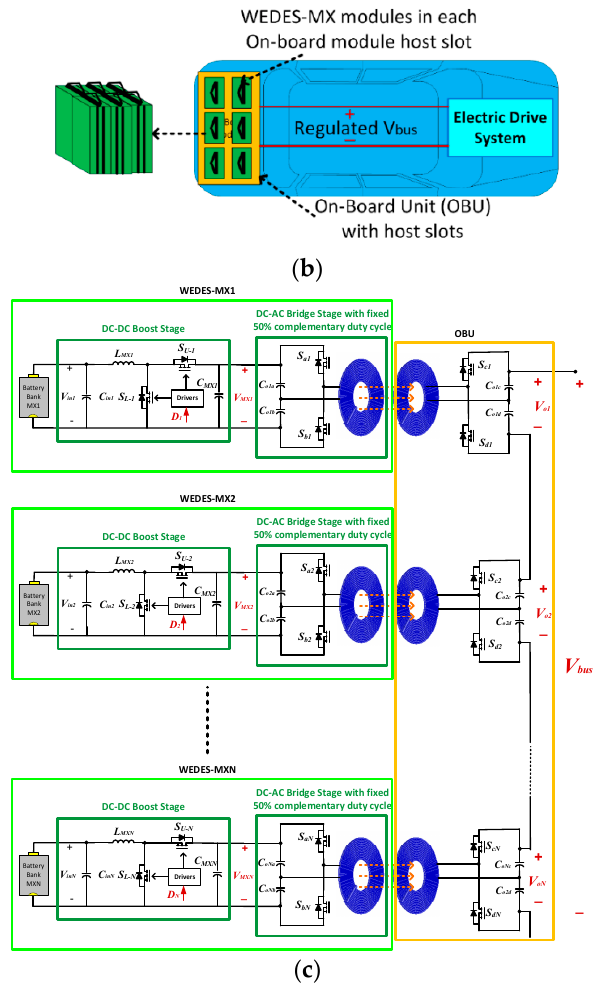
Figure 1. Illustration diagrams of battery system for electric vehicle (EV) application. ( a ) The conventional battery pack and electrics drive system in EVs, ( b ) the wireless distributed and enabled battery energy storage (WEDES) battery system in EVs, and ( c ) example circuit diagram of the WEDES system [1].